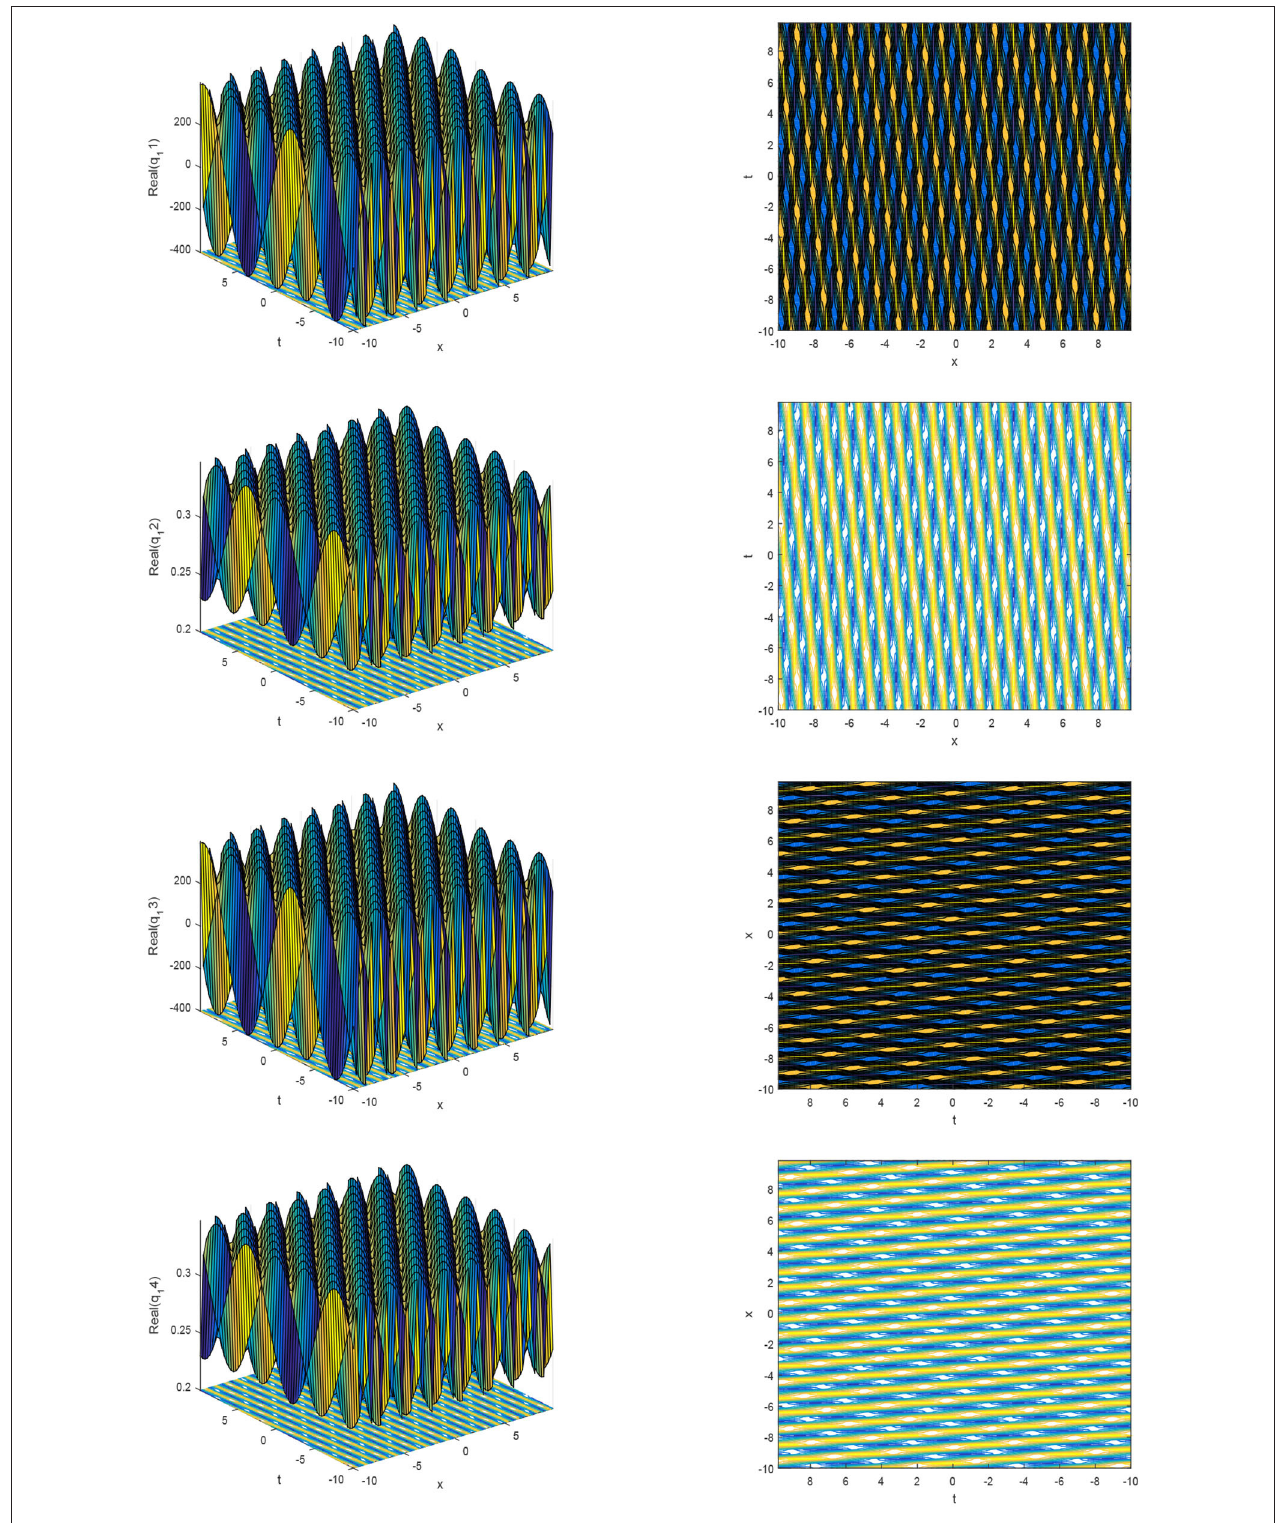
FIGURE 3 | The 3D plots and contour plots of the real part of solution q 11 ( x , t ) to q 14 ( x , t ) for different parameters.